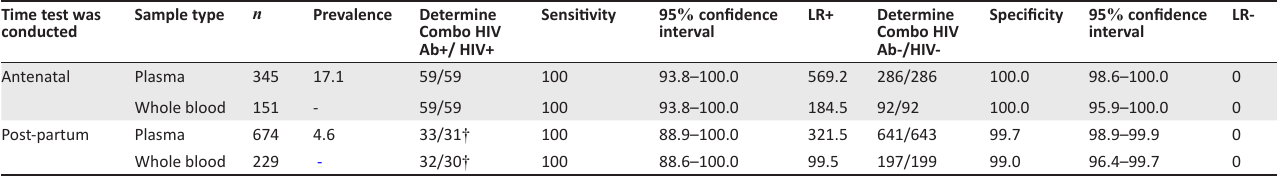
TABLE 2: Performance of Determine Combo rapid test HIV antibody (DC RT Ab) component in plasma and whole blood samples in women tested antenatally and post-partum. Time test was Sample conducted